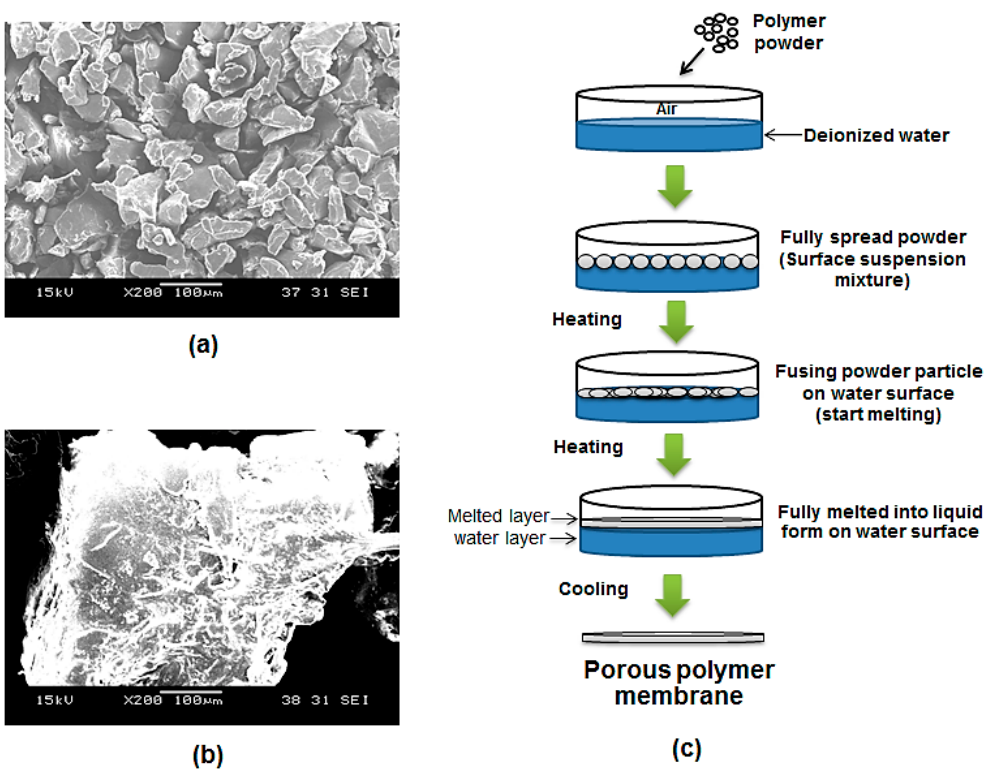
Figure 7. ( a ) SEM image of 100 µm dry PCL powder at ×200; ( b ) SEM image of 500 µm dry PCL powder at ×200; ( c ) Schematic illustration of a micro-porous membrane fabrication starting from a micro-particles powder layer forming a surface suspension mixture.